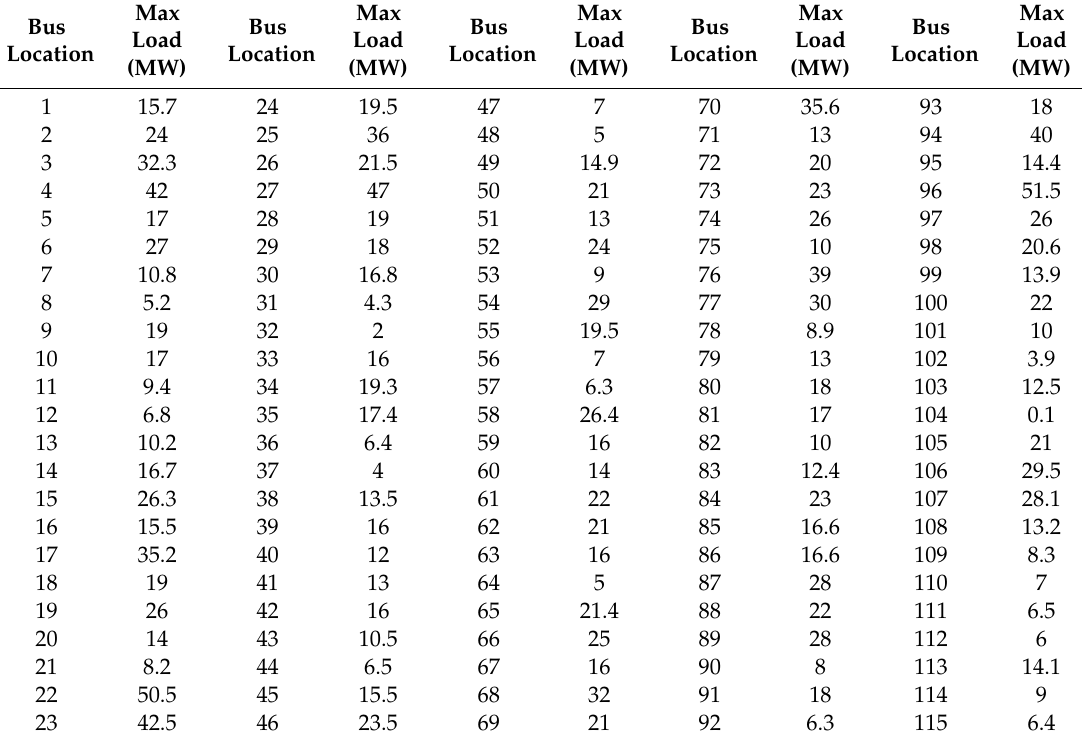
Table 2. The peak load of each BREC 63 / 20 kV